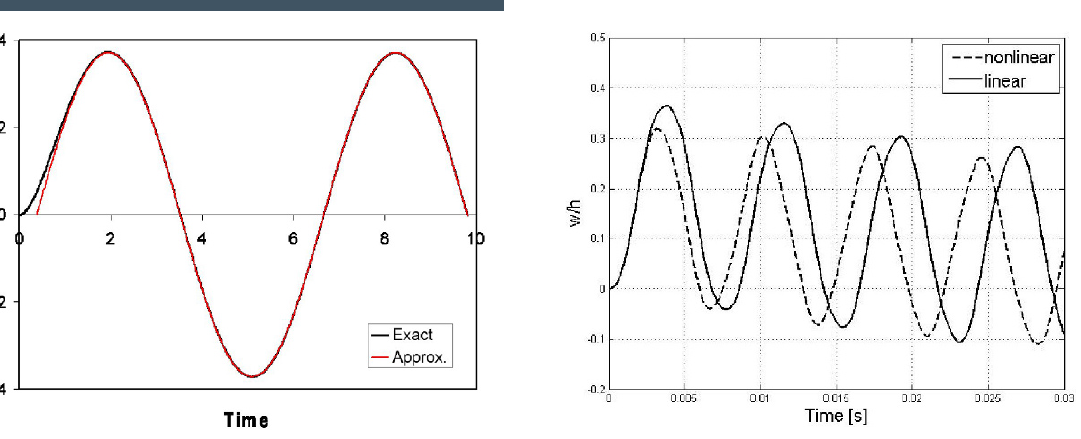
Figure 5. One-mode approximation for the response of a square plate to a Friedlander pulse.